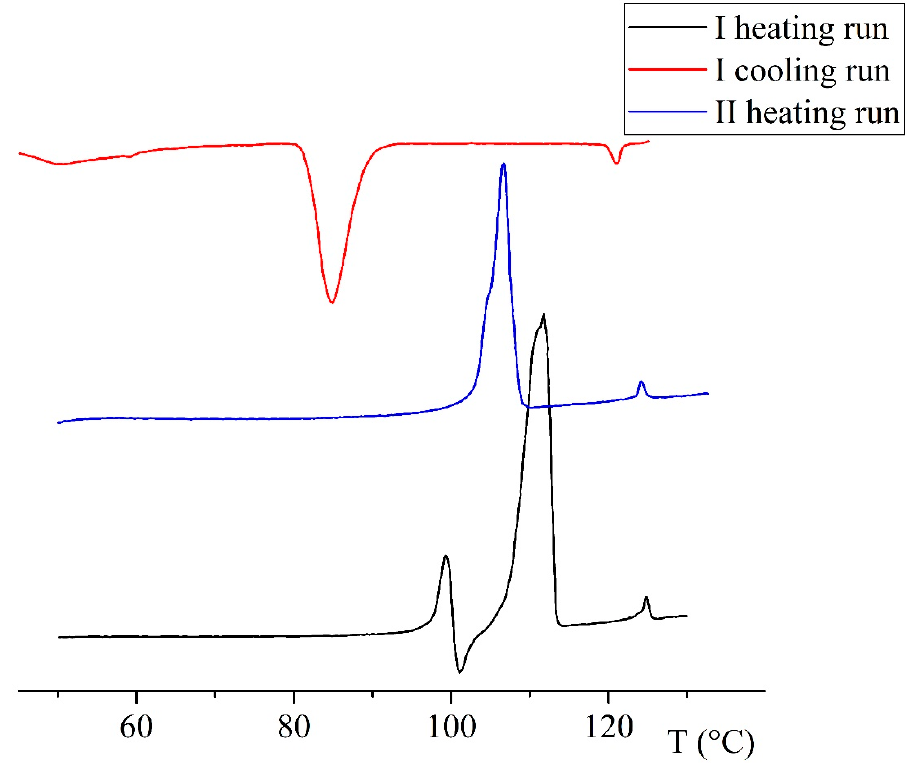
Figure 4. DSC thermograms of A11O-6ONNi: (black) first heating; (red) first cooling run; and (blue) second heating run at 10 K/min scanning rate.